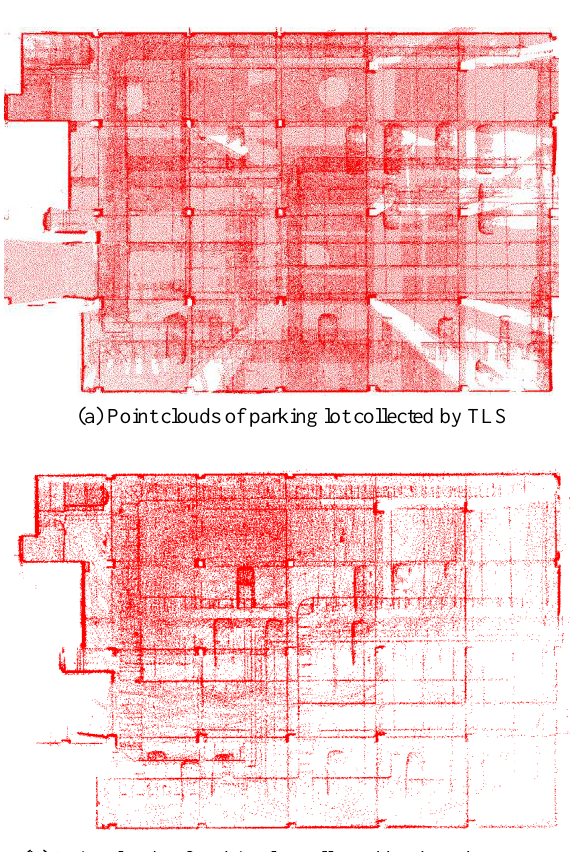
Figure 4. Indoor mapping result in a parking lot